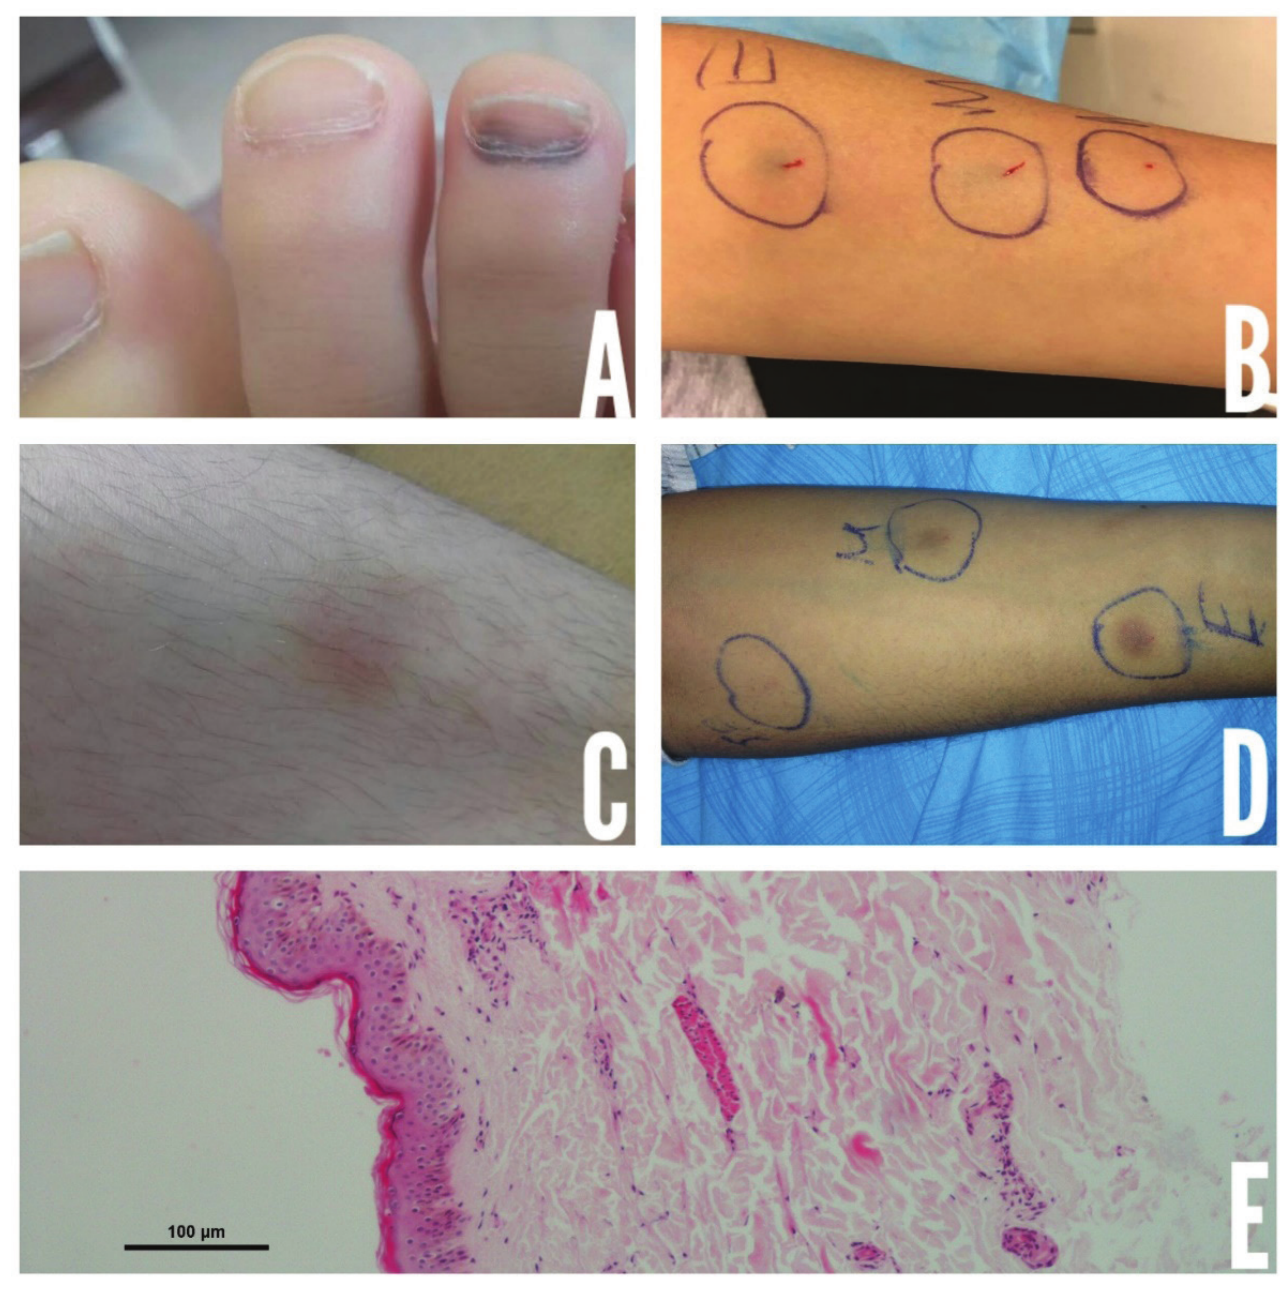
Figure 1 - Specific characteristics of cases: (A) Ecchymosis in the nail bed of Case 1; (B) Result of intradermal skin test in Case 1; (C) Ecchymosis on leg front of Case 2; (D) Result of intradermal skin test in Case 2; (Е) Erythrocyte extravasation in the dermis and a mixed type cell infiltration in the perivascular-interstitial area in the pathology of Case 1 (HE,